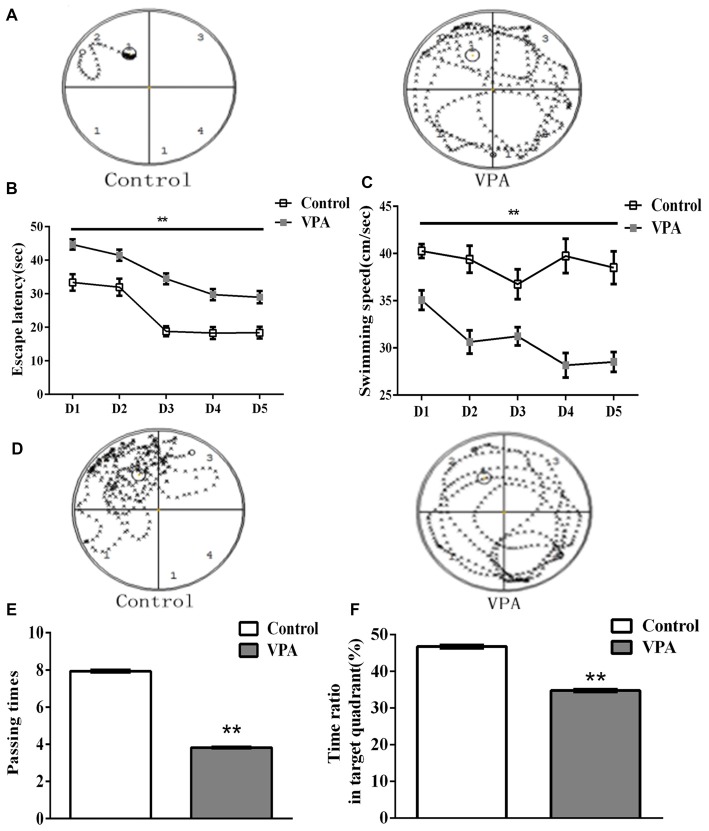
VPA rats exhibited spatial learning and memory impairment in Morris water maze test.  (A) Representative swimming paths of control (left) and VPA-treated (right) rats during the probe trial session in the Morris water maze test. (B) VPA-treated rats had significantly longer escape latency to find the platform than that in control rats (**p < 0.01). (C) VPA-treated rats exhibited slower swimming speed than control rats in the place navigation test (**p < 0.01). (D) Swimming path map of control (left) and VPA-treated (right) crossing different quadrants after removing the platform in the Morris water maze test. (E) VPA rats displayed a reduced number of platform passing (**p < 0.01). (F) VPA-treated rats exhibited less time in target quadrant compared with control rats (**p < 0.01).